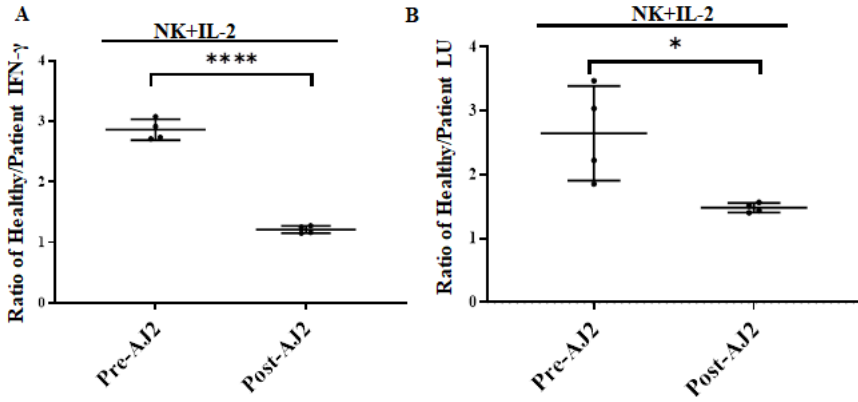
Figure 7. Increased IFN- γ secretion and cytotoxicity in cancer patients’ NK cells after oral AJ2 sup- plementation. Freshly purified NK cells (1 × 10 6 cells/mL) from cancer patients and those of the healthy individuals were treated with IL-2 (1000 U/mL) for 18 h before supernatants were harvested to determine IFN- γ secretion using ELISA (Pre-AJ2). Cancer patients were on oral supplementation of AJ2 for four weeks before we analyzed their NK cells. NK cells were treated with IL-2 (1000 U/mL) for 18 h before supernatants were harvested to determine IFN- γ secretion using ELISA (Post-AJ2). Ratio of secreted IFN- γ between healthy and patient NK cells were determined at pre- and post-AJ2 oral supplementation ( n = 4) ( A ). Freshly purified NK cells (1 × 10 6 cells/mL) from cancer patients and those of the healthy individuals were treated with IL-2 (1000 U/mL) for 18 h before they were used as effectors in cytotoxicity against OSCSCs using standard 4 h 51 Cr release assay. LUs were determined as described in Figure 2. (Pre-AJ2). Cancer patients were on oral supplementation of AJ2 for four weeks before analysis of their NK cells. NK cells were treated with IL-2 (1000 U/mL) for 18 h before they were used as effectors in cytotoxicity against OSCSCs using standard 4 h 51 Cr release assay. LUs were determined as described in Figure 2. (Post-AJ2). Ratio of cytotoxicity be- tween healthy and patient NK cell-mediated cytotoxicity were determined at pre- and post-AJ2 oral supplementation in cancer patients ( n = 4) ( B ). **** ( p value < 0.0001), * ( p value 0.01–0.05). 4. Discussion Previous studies from our laboratory and those of the others demonstrated defects in NK cell function in cancer patients (Supplementary Table S2); however, the underlying mechanisms for such defects was not clearly delineated, nor is it known whether other immune effectors such as monocytes that are known to activate NK cells are also defective in their function in cancer patients [7,47]. Therefore, in this paper, we show that NK cell- mediated cytotoxicity and induction of IFN- γ in PBMCs of cancer patients are signifi- cantly defective when compared to those obtained from healthy donors. Although the defect can be seen in most in-vitro treatments tested including those triggered by IL-2 or the combinations of IL-2 with anti-CD16 mAbs, or IL-2 with anti-CD3/28 mAbs or IL-2 with sAJ2 in PBMCs, the most significant defect was seen in those treated with IL-2 and anti-CD16 mAbs, and the least in those treated with IL-2 and sAJ2. Since we previously observed decreased expression of CD16 on patient NK cells [46] and significant differ- ences in the function of PBMCs when they were activated with IL-2 and anti-CD16 mAbs, we undertook studies to understand the underlying mechanisms of the insufficient NK cell activation by anti-CD16 mAbs. We purified peripheral blood NK cells and studied their functions following cocultures with autologous and allogeneic monocytes obtained from cancer patient and those of the healthy individuals in the presence of IL-2 and anti- CD16 mAbs activation and compared the effect to those activated with IL-2 and sAJ2. As presented in the results section, the levels of cytotoxicity were decreased when cancer pa- tients’ or healthy individuals’ NK cells were cultured in the presence of patient mono- cytes, as compared to those of healthy monocytes in a representative experiment. How- ever, when we compiled the data from different donors, the differences were less dra- matic, but the patterns remained consistent in the presence of IL-2 treatment. This is likely